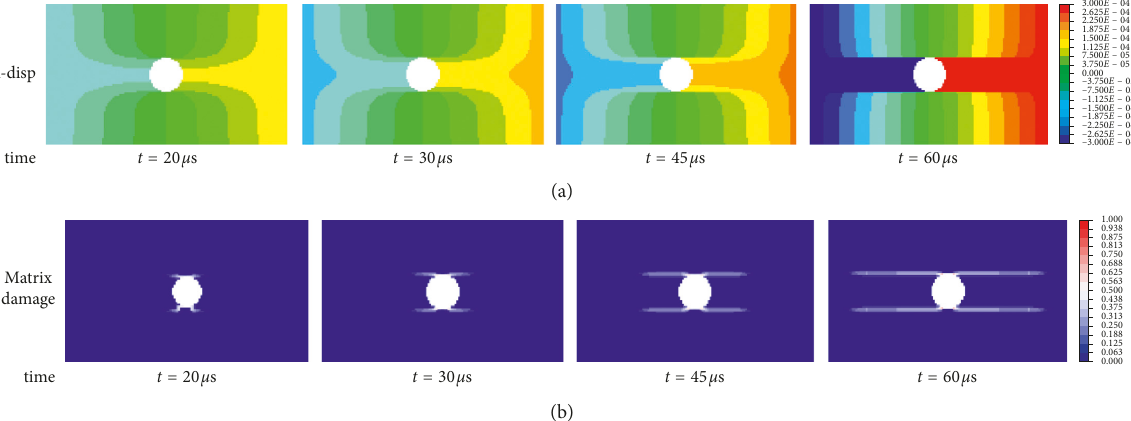
Figure 14: Progressive failure process of A-0 specimen with a hole under tension: (a) displacement (m) and (b) damage (0-1).